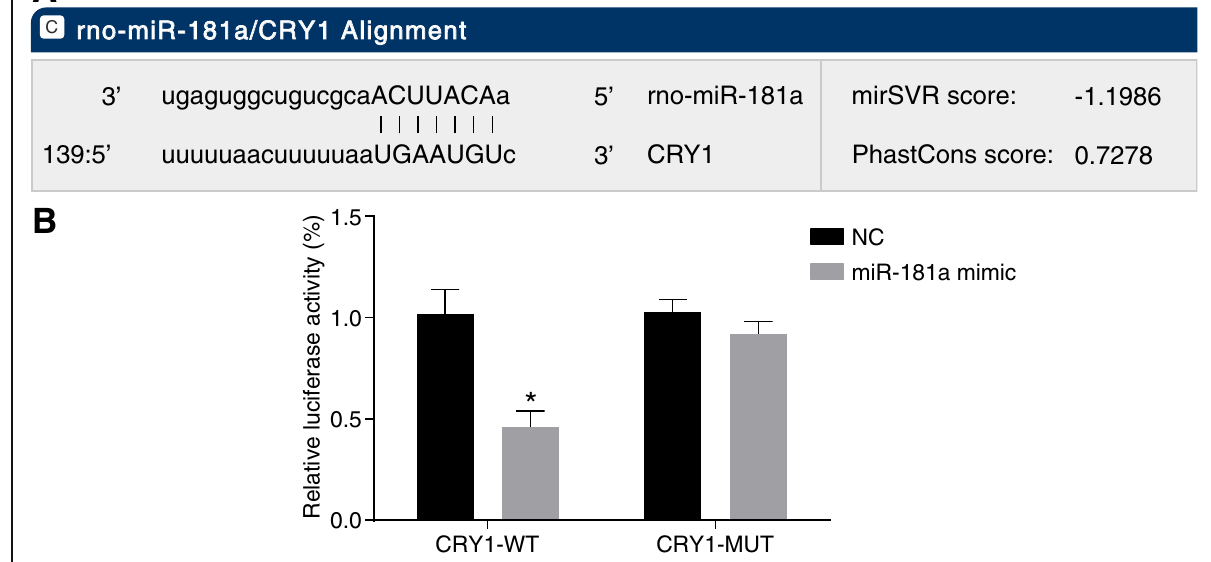
Fig. 8 A targeting/regulatory relationship between miR-181a and CRY1 is identified by the target prediction program and determination of luciferase activity. Notes: Panel a , predicted binding sites for miR-181a in the CRY1 3 ’ UTR; Panel b , luciferase activity of cells transfected with CRY1 – 3 ’ UTR-WT and CRY1 – 3 ’ UTR-MUT; * , p <0.05 vs. the NC group; the data are presented as the mean±standard deviation, analyzed by t -test; the experiment was